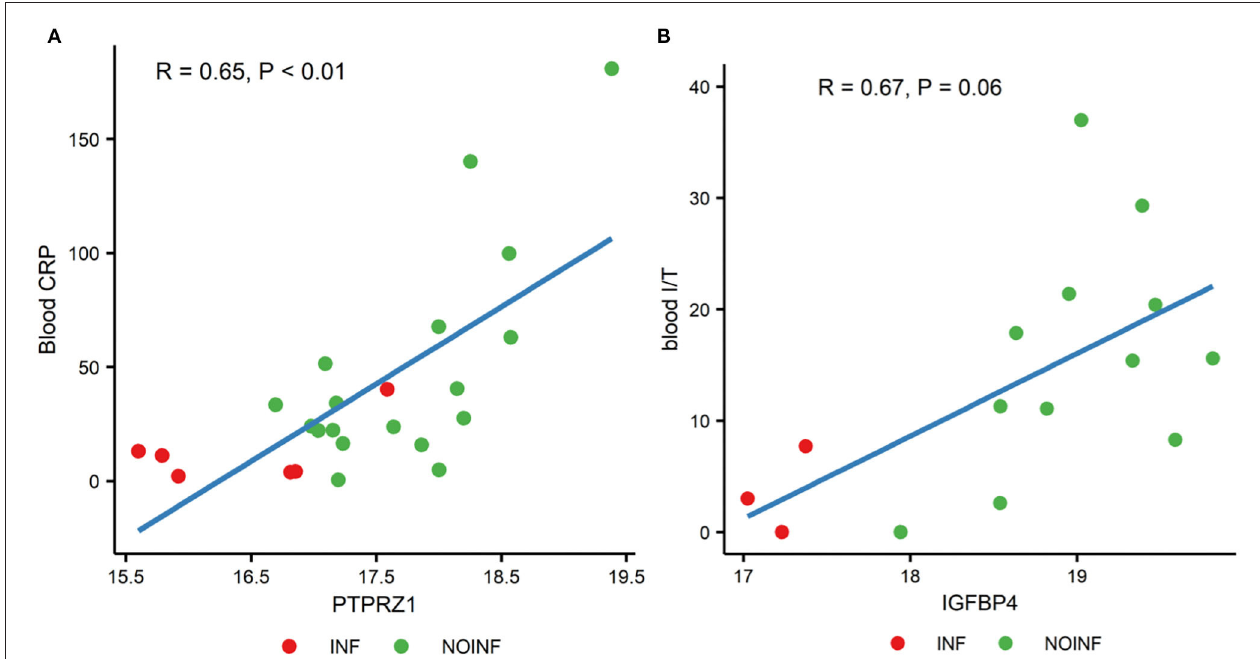
FIGURE 2 | Correlations between the levels of PTPRZ1 and blood CRP (A) and the levels of IGFBP4 and the ratios of blood immature and total neutrophils [blood I/T, (B) ].